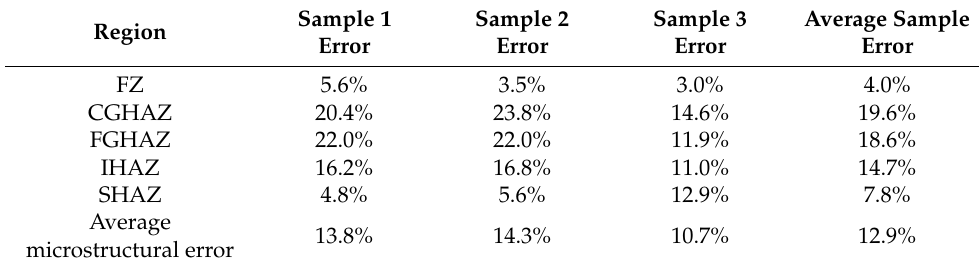
Table 9. Comparison between the average errors relative to each zone for Model